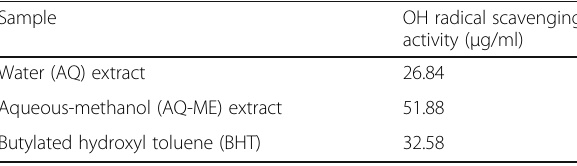
Table 1 IC 50 values of MO leaf extracts and butylated hydroxy tolune (BHT) against hydroxyl free